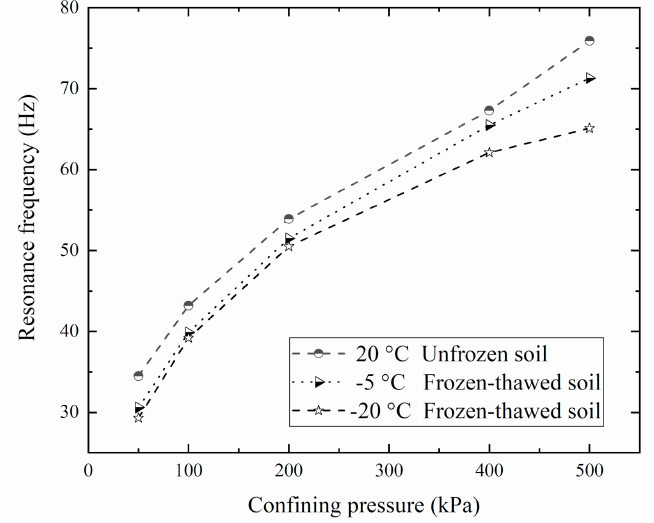
Figure 2. Resonance frequency of thawed soft clay. The resonance frequency increases with increasing confining pressure for three different temperature soft